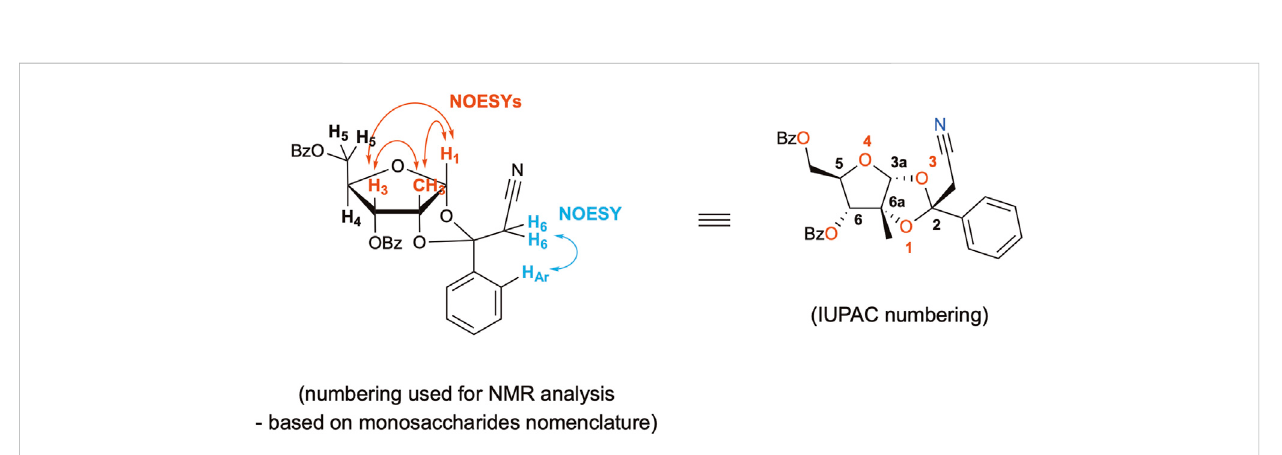
FIGURE 2 Proposed structure of by-product 10 and main NOESY